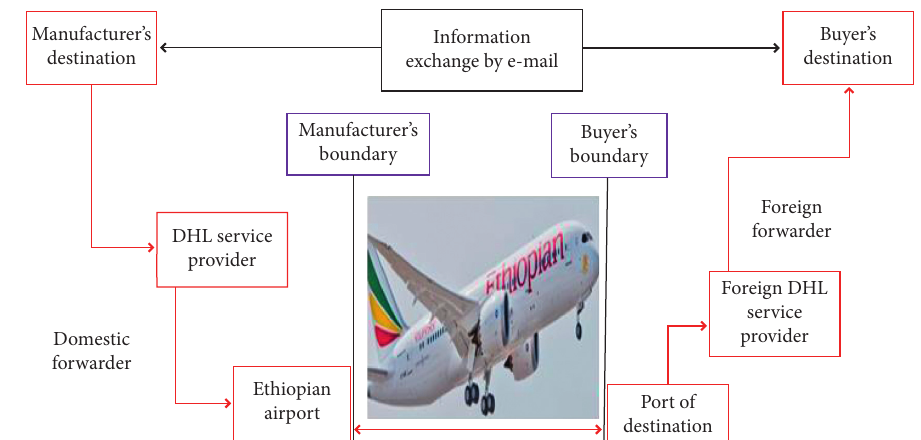
Figure 2: Existing sample approval application process for export orders.